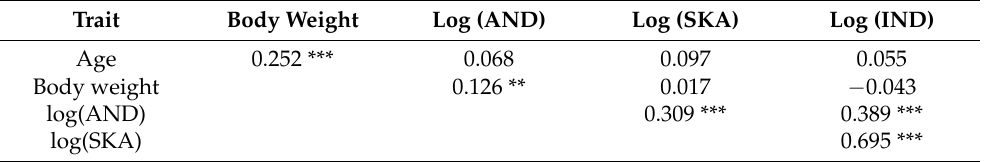
Table 2. Pearson product-moment correlations between body weight at fat sampling, age at training with the dummy sow, and log-transformed boar taint compound concentrations 1 .